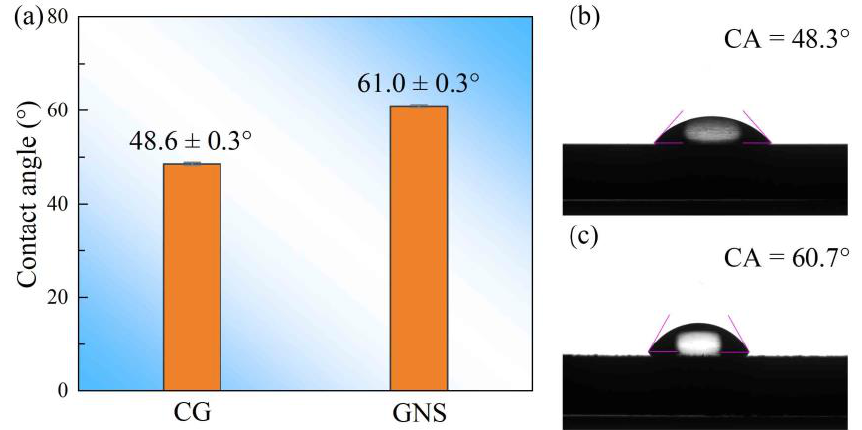
Figure 6. ( a ) Water contact angle. ( b ) Water droplet on the CG sample. ( c ) Water droplet on the GNS